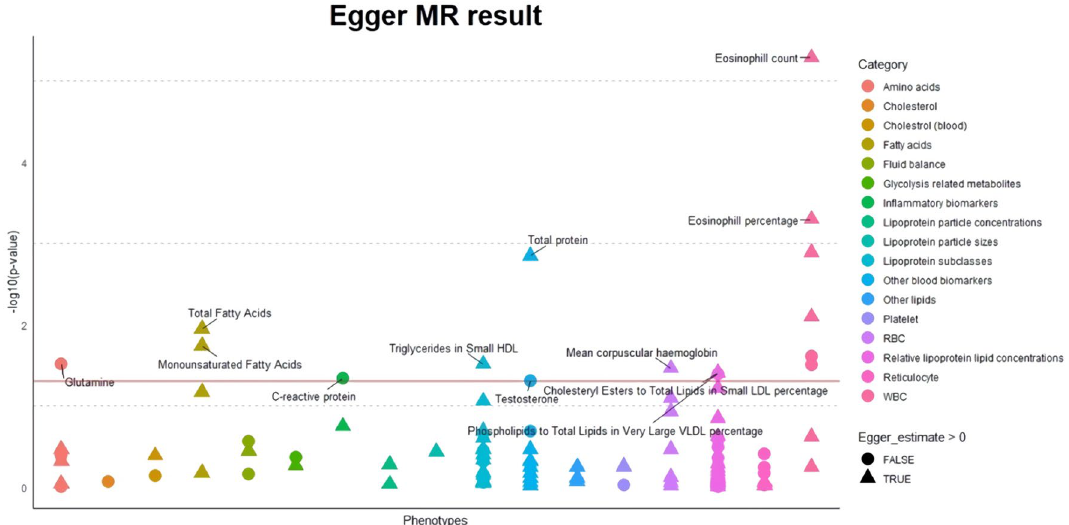
Figure 5. A PheWAS plot of linear MR causal estimates from MR-Egger regression. The horizontal red line is the p value threshold of 0.05. Each color indicates a different group of biomarkers. The two most significant in each group with p values < 0.05 were labeled. The shape of the points indicates the direction of the causal effect. Triangles are the biomarkers that contribute to higher delta age, and circles are the biomarkers that contribute to lower delta